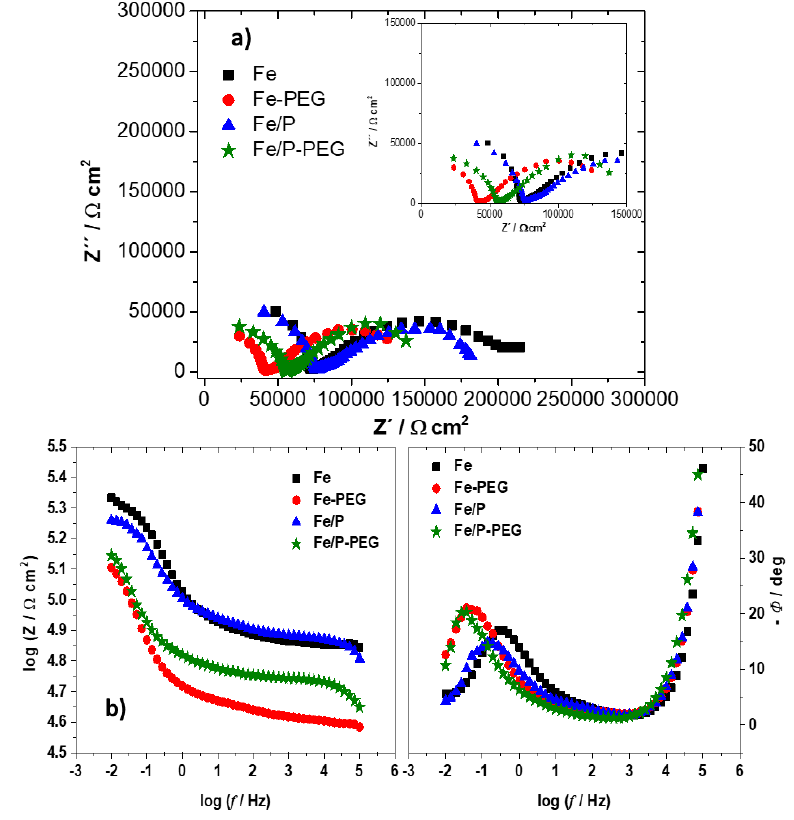
Figure 5. Nyquist diagram ( a ) and Bode diagram ( b ) of iron-based foams (Fe, Fe-PEG, Fe / P, and Fe / P-PEG) in Hanks’ solution.